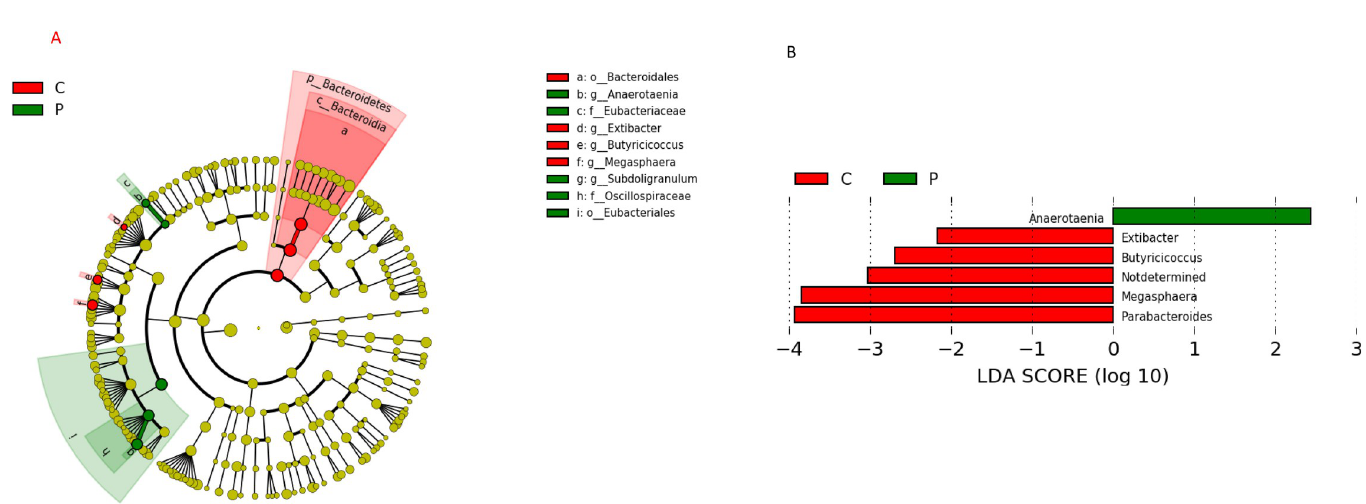
Fig 4. Linear discriminant effect size analysis to distinguish the differential microbiota between the PMDs group and control group. (A) Cladogram showing the most differentially abundant taxa between the PMDs group (P) and control group (C). Taxa enriched in the PMDs group are indicated in green and taxa enriched in the control group are indicated in red. The brightness of each dot is proportional to the respective effect size. (B) Comparison of the LDA scores between the P and C groups at the genus level. Abbreviations: LDA, logarithmic linear discriminant analysis; PMDs, premenstrual disorders; P, premenstrual disorders group; C, control group.